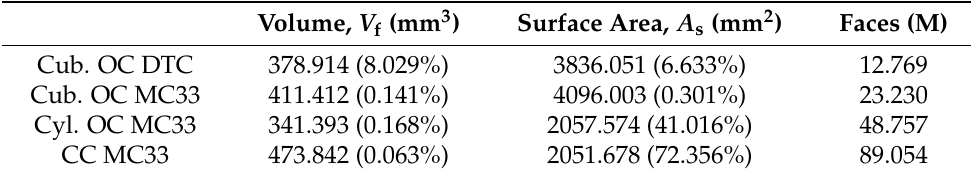
Table 3. Comparison between the Double-time Cubes and the Marching Cubes 33 algorithms. The error in volume with respect to the real values is provided between brackets. The error in surface area is calculated with the values obtained with